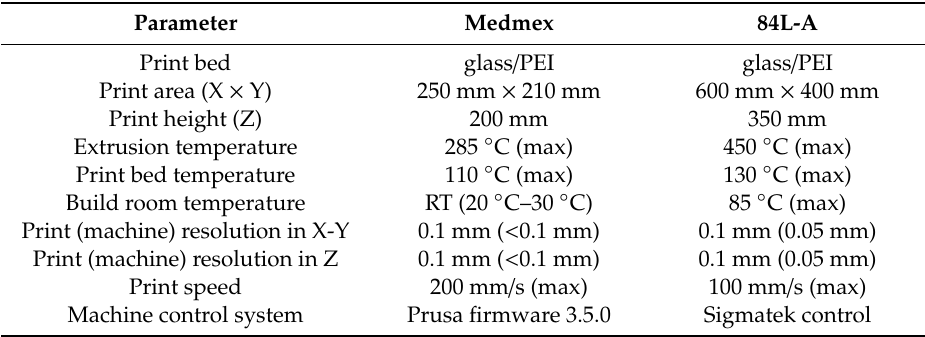
Table 4. Performance specifications of the